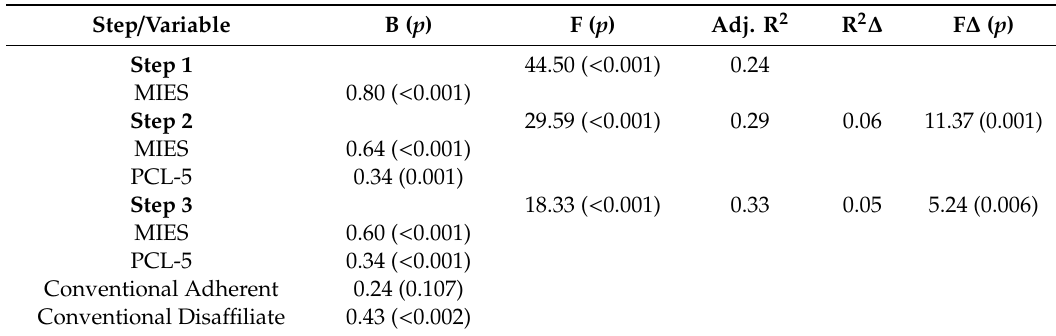
Table 2. Exposure to Potentially Morally Injurious Events, PTSD Symptoms, and MMPSF conventional subscales as predictors of Moral Injury Questionnaire